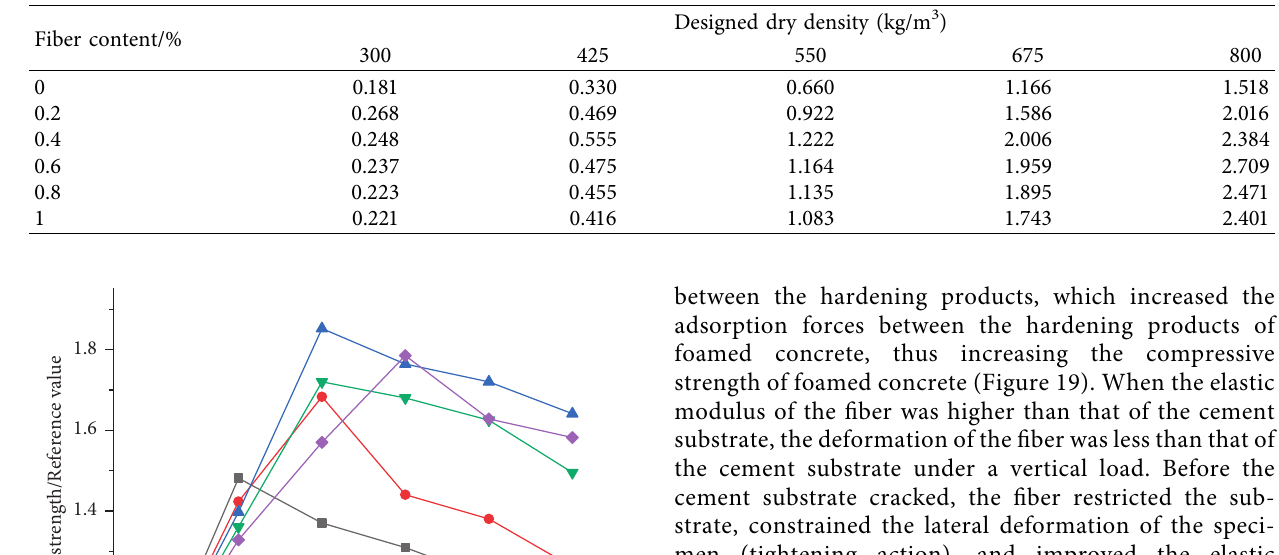
Table 6: Flexural strength results of glass fiber cast-in-situ foamed concrete (unit: MPa).